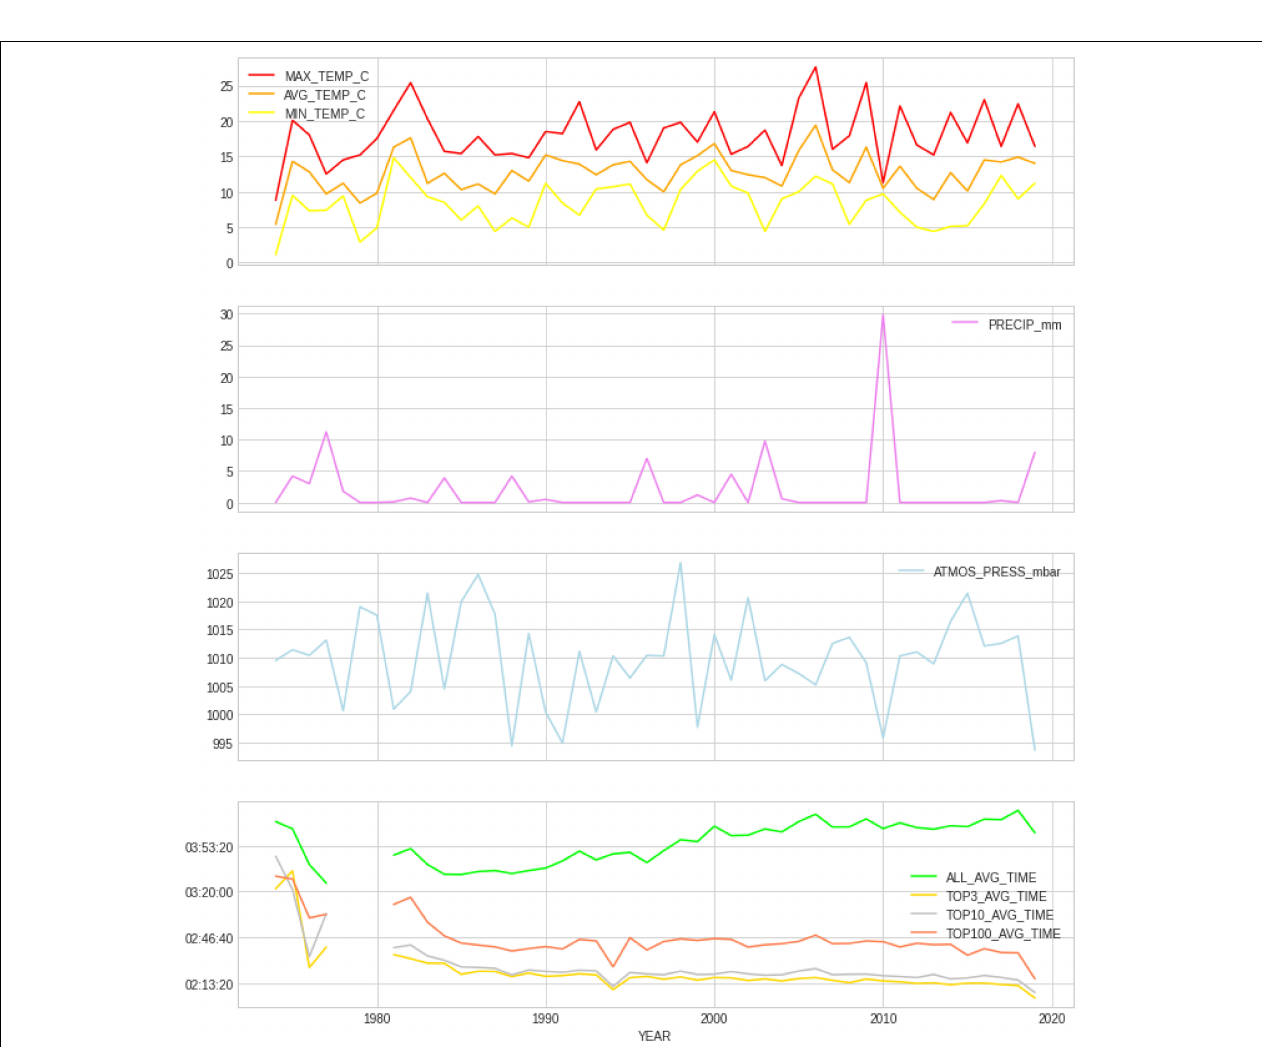
FIGURE 2 | Average finish times by performance group (all, top 3, top 10, and top 100) along with profiles of measured weather variables from 1974 to 2019. PRECIP, precipitation in mm; ATMOS_PRESS, atmospheric pressure in mbar; AVG_TEMP, average temperature in degrees Celsius; MAX_TEMP, maximum temperature in degrees Celsius; MN_TEMP, minimum temperature in degrees